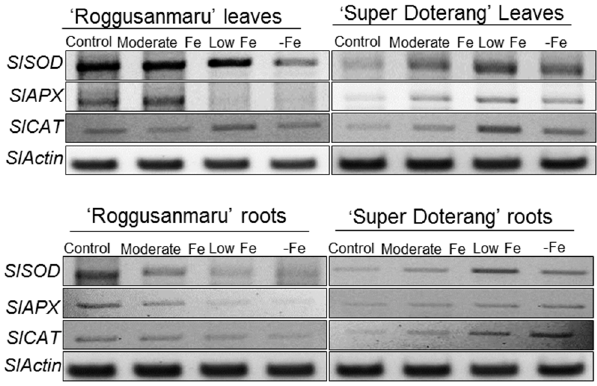
Figure 9. Semi-quantitative RT-PCR analysis of antioxidant mechanism related genes ( SlAPX , SlSOD and SlCAT ) in shoots and roots of “Roggusanmaru” and “Super Doterang” tomato cultivar ( SlActin acted as a normalized housekeeping gene). Plants were grown in Fe-sufficient (control); moderate Fe; low Fe; and Fe-deficient (–Fe) Hoagland nutrient medium for 10 days.